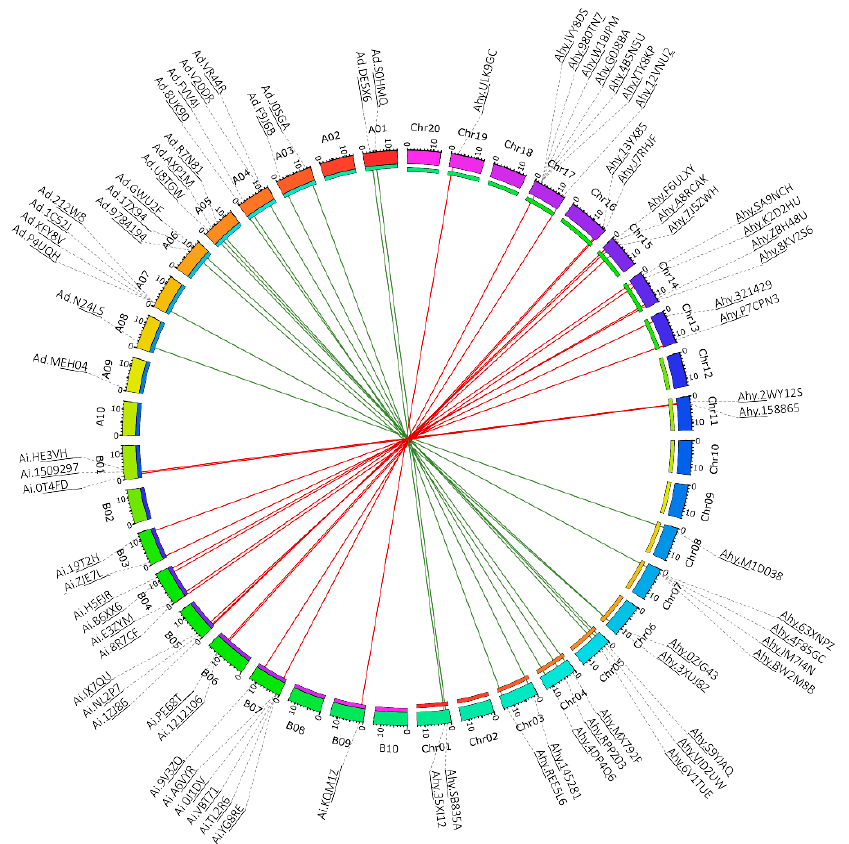
Figure 4. Synteny mapping of LysM-RLK genes in Arachis chromosomes. The circle represents each chromosome of A. hypogaea , A. duranensis , and A. ipaensis . Synteny relationships were lined by Circos “http://circos.ca/”(accessed on 9 June 2022). Lines indicate synteny from each diploid parental and cultivated peanut. Figure was drawn using Circos.